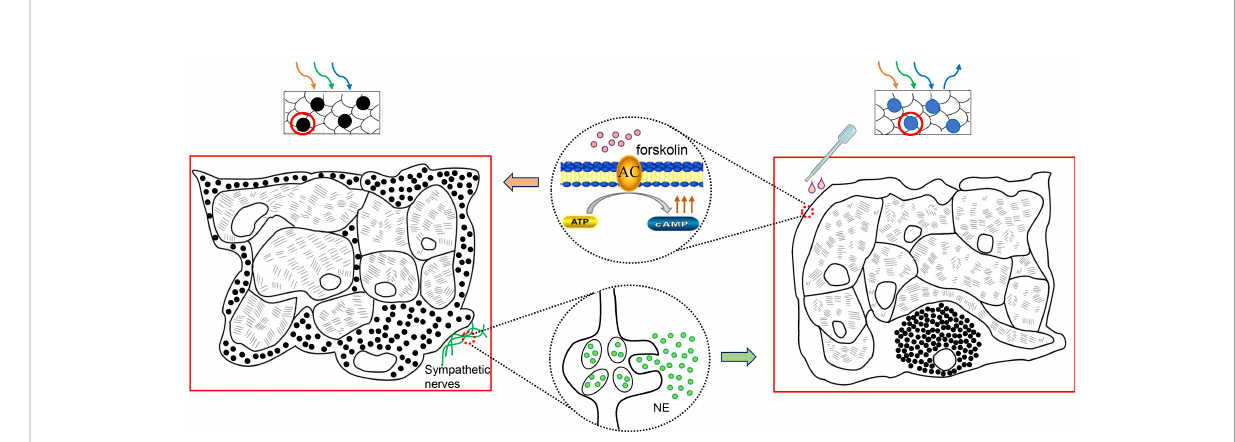
FIGURE 7 Schematic graph shows color changes between blue and black spots. The sympathetic release of NE drives the aggregation of melanosomes to the perinuclear area. Only the light re fl ected by iridophores is visible, and the spots appear blue. Forskolin can induce skin darkening by elevating intracellular cAMP. The melanosomes dispersed distally, surround or cover the iridophores and absorb light, giving the spots a black